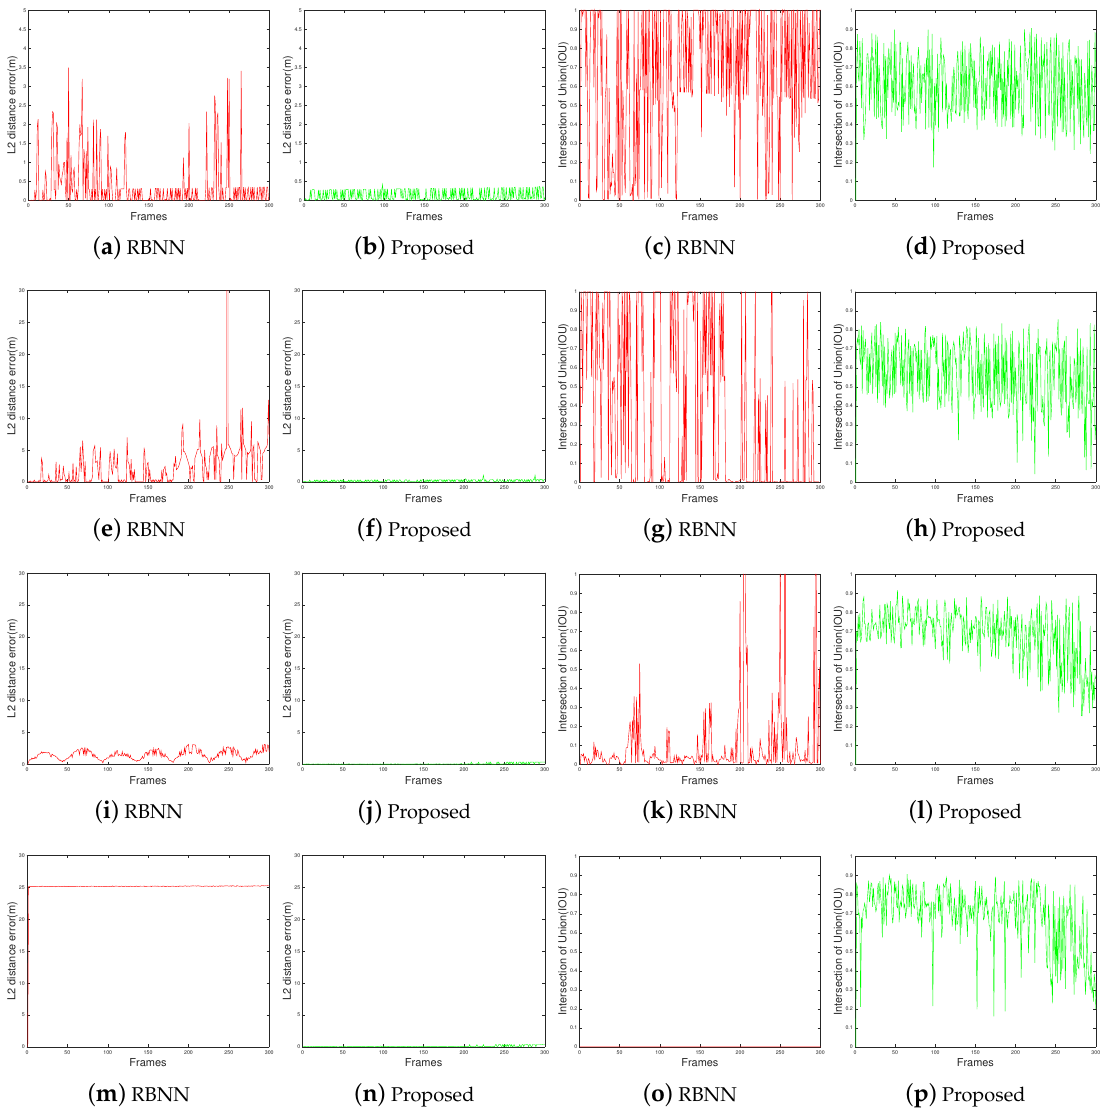
Figure 12. Euclidian distance and intersection over union (IOU) measurement. ( a – d ) result using dataset #1, ( e – h ) result using dataset #3, ( i – l ) result using dataset #2, ( m – p ) result using dataset